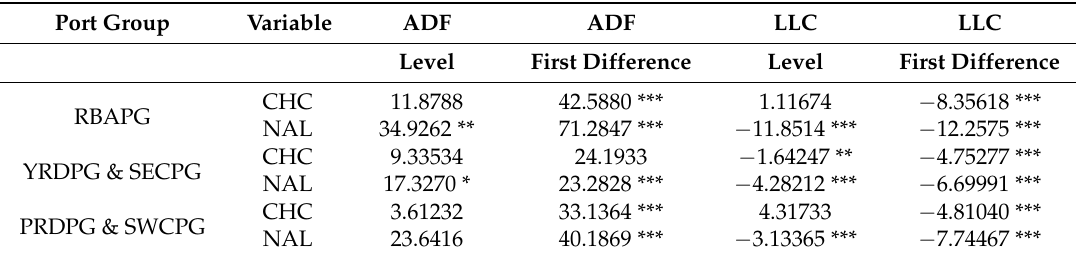
Table 1. Pool unit root test.